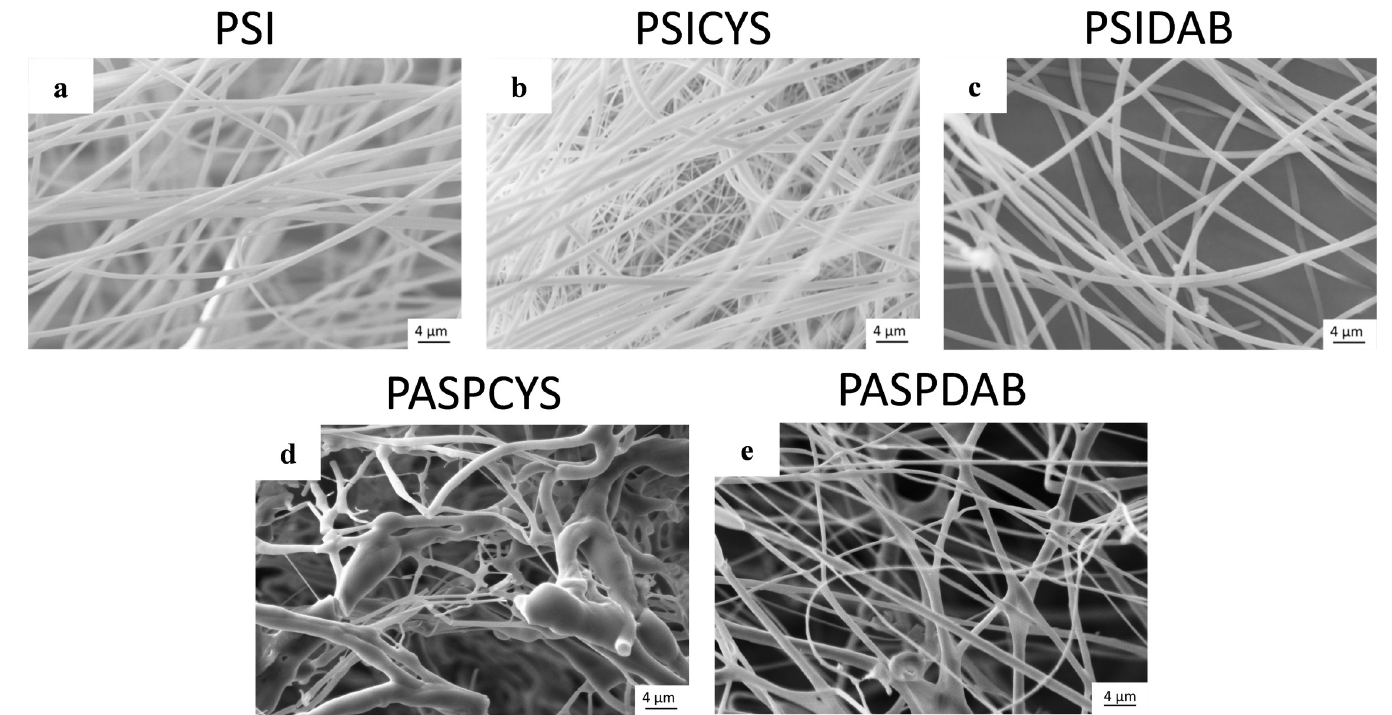
Fig 2. SEM micrographs of electrospun PSI fibers (a), PSICYS fibers (b), PASPCYS fibers (c), PSIDAB fibers without compression (d), SEM (e) and multiphoton micrographs (f) of freeze-dried PASPDAB fibers.